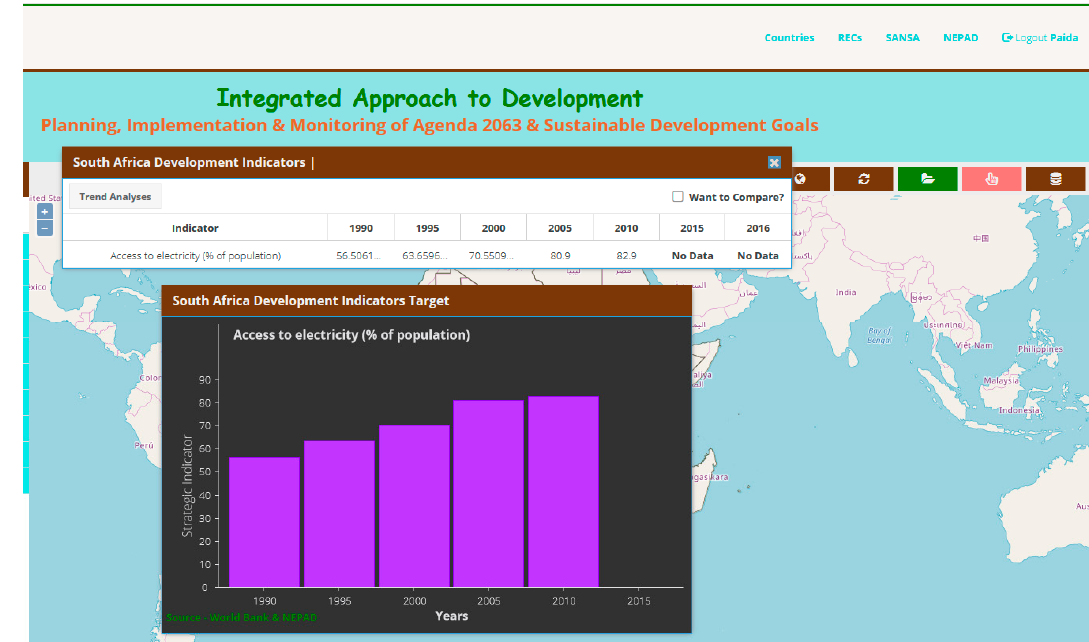
Figure 8. High-level strategic impacts, indicators, and the Agenda 2063 targets.